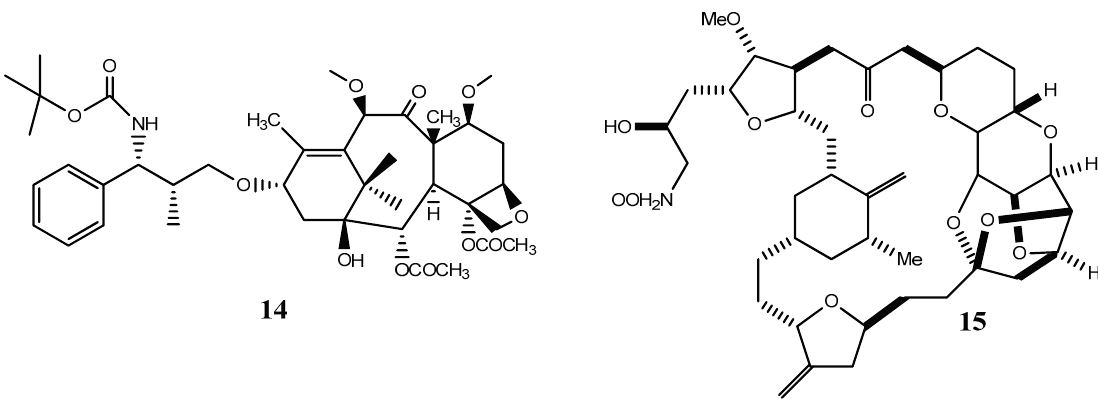
Figure 9. Chemical structure representation of FDA approved oxygen-based heterocycles, Cabazitaxel ( 14 ), with an oxetane ring, and Eribulin ( 15 ) with tetrahydrofuran and tetrahydropyran rings